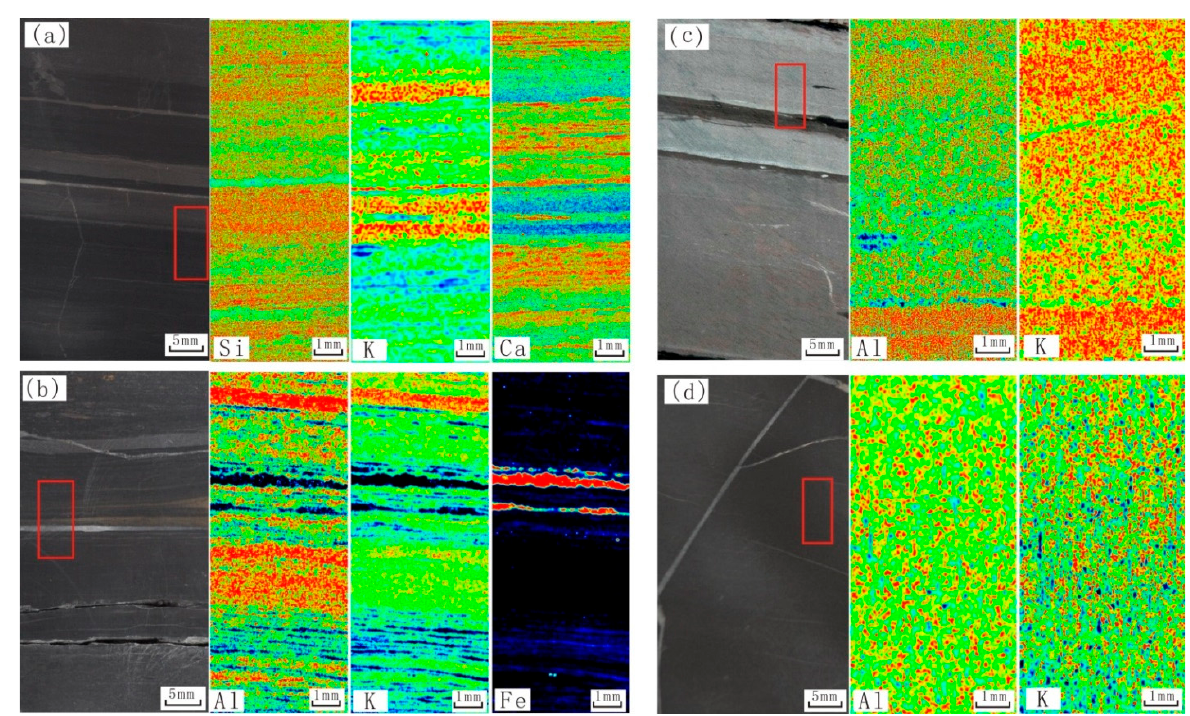
Figure 6. X-ray fluorescence (XRF) elements scan figure of different shale lithofacies in the upper Es3 member of Qibei slope. ( a ) Thin laminar shale, 3899.2 m, felsic, clayey, and calcareous lamina interbedding; ( b ) thin laminar shale, 3993.28 m, felsic, clayey and pyrite lamina interbedding; ( c ) thick laminar shale, 4377.2 m, the content of felsic in the upper bright lamina is high, the content of clay in the lower dark lamina is high; ( d ) massive mudstone, 3894.2 m, clayey and felsic are randomly distribute .